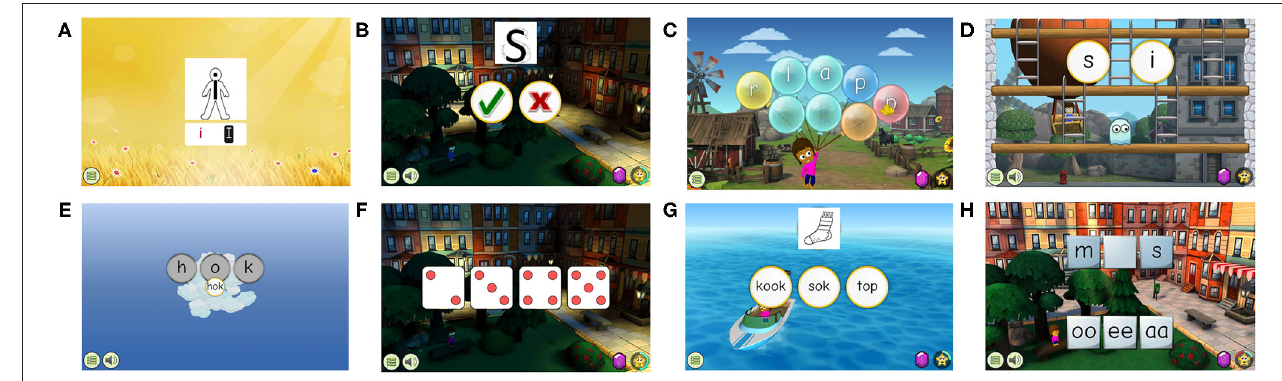
FIGURE 2 | Examples of the different types of reading-related mini-games in GraphoGame Flemish. (A) , Grapheme story. (B) , Auditory discrimination. (C) , Visual discrimination. (D) , Grapheme-phoneme coupling. (E) , Phoneme blending. (F) , Phoneme counting. (G) , Reading. (H) , Spelling.